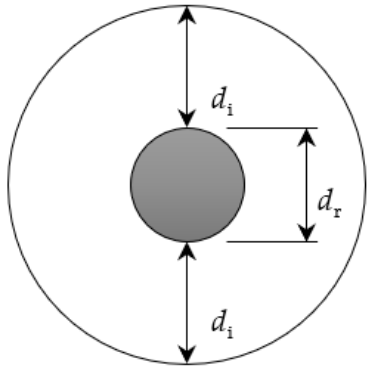
Figure 12. Demonstration of cross-section of conductor with ice covering.